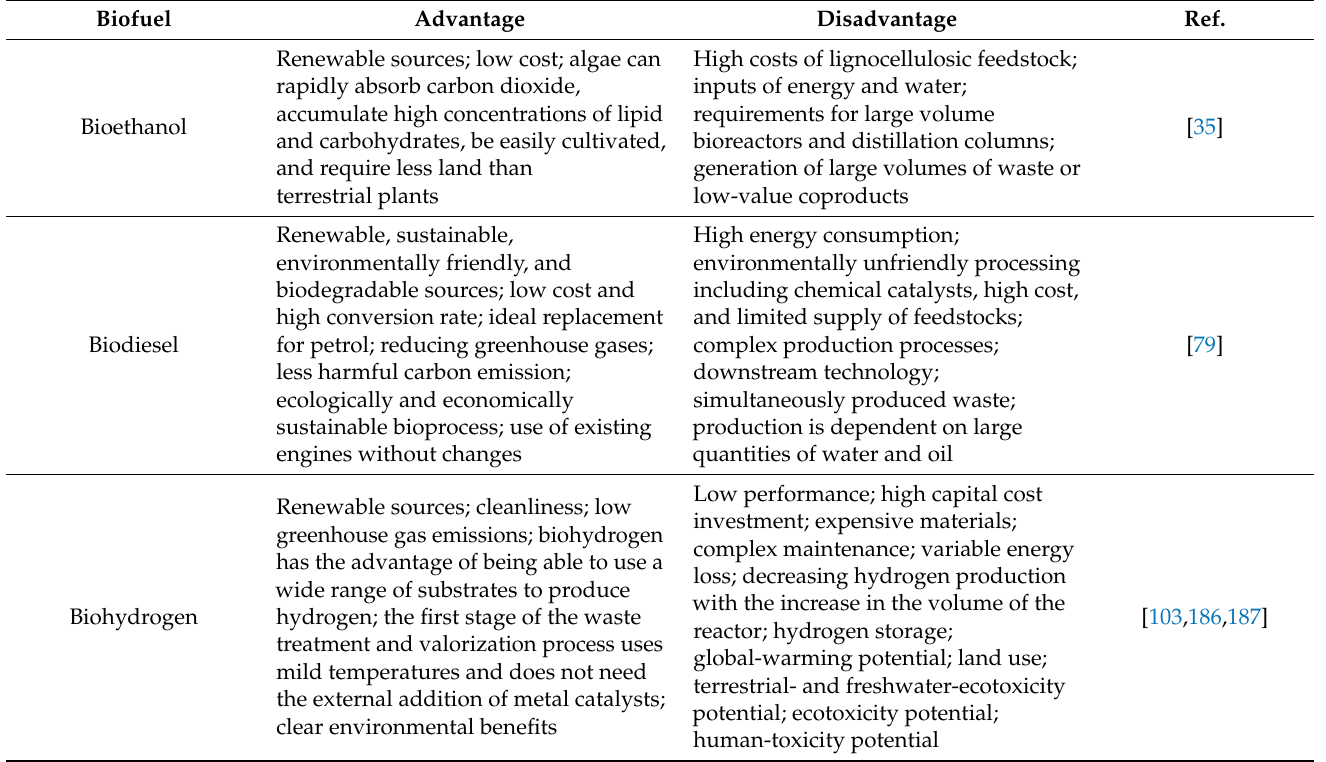
Table 6. Advantages and disadvantages of biofuel